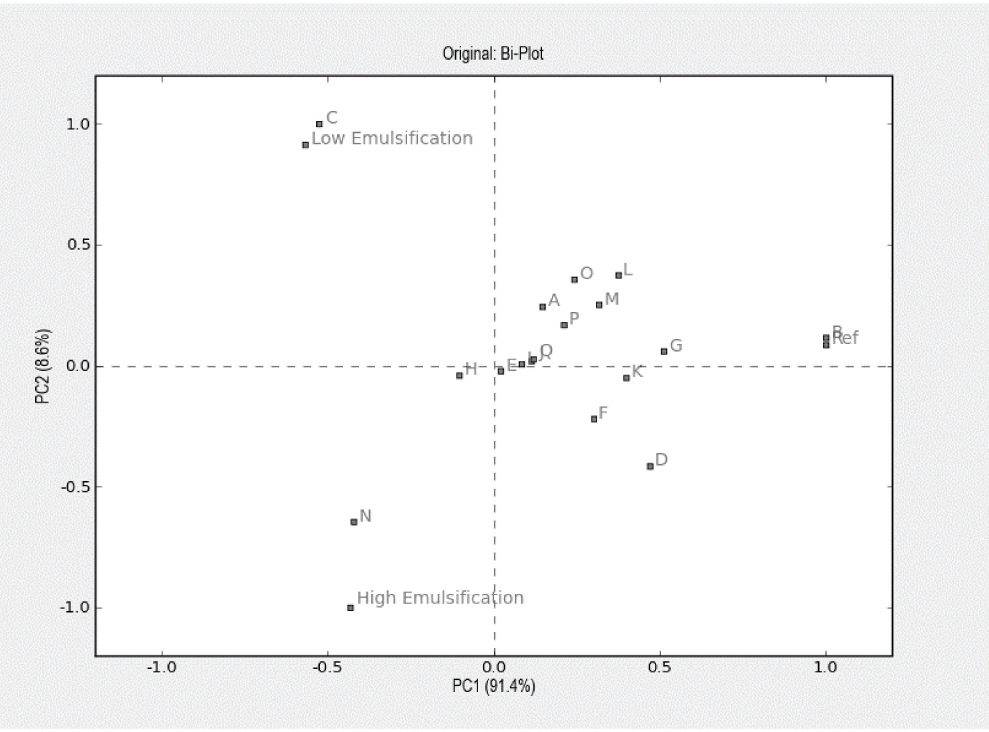
Figure 2. Principal component analysis (PCA) illustrating the sensory and instrumental characteristics of the experimental and commercial reference (Ref.) mayonnaises. The PCA plot shows 100% of the explained variance, meaning that the total variance is explained by two dimensions. A: Shiny; B: